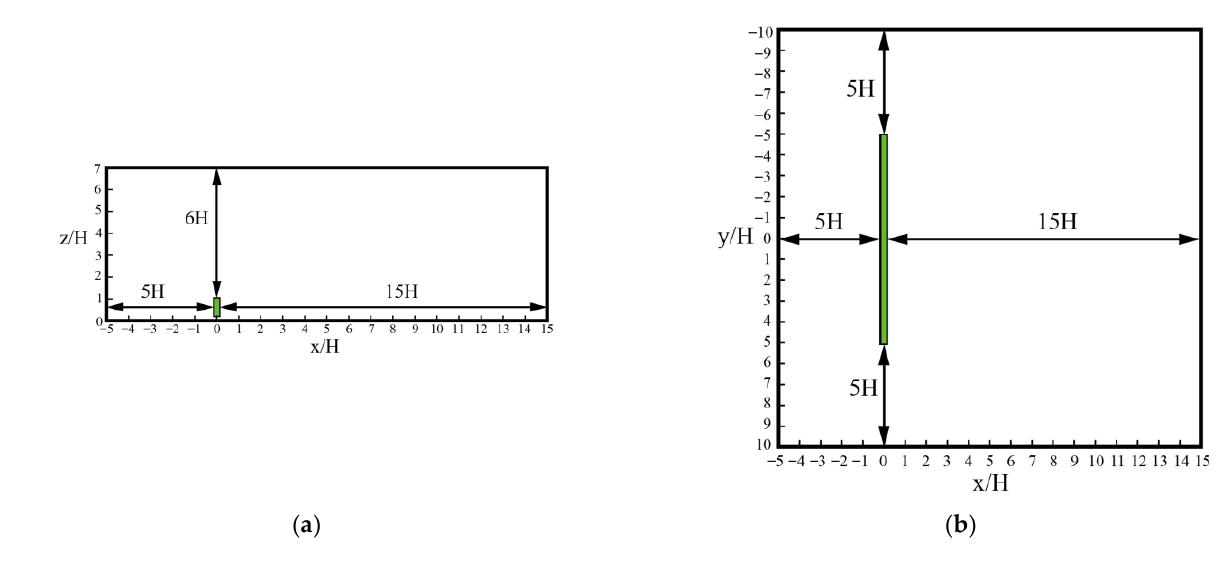
Figure A1. Size of the computational domain, ( a ) lateral view, ( b ) plan view. The green rectangular marks the canopy region occupied by trees. Table A1. Meshing schemes in the sensitivity study.